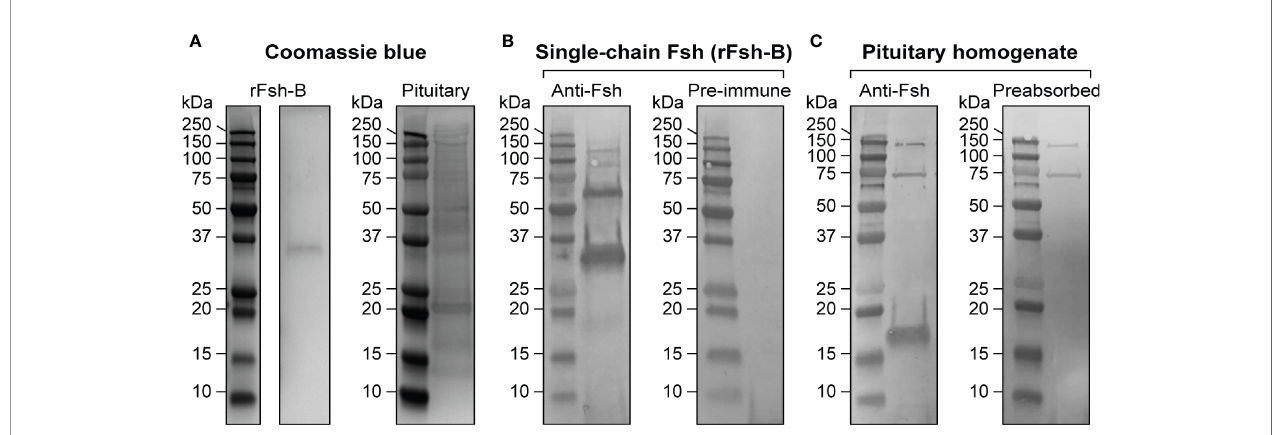
FIGURE 2 | Characterization of a speci fi c antiserum for Atlantic salmon Fsh. (A) Coomassie blue protein staining of the single-chain Fsh protein (rFsh-B) and of a pituitary homogenate. (B) Representative immunoblots of rFsh-B using Fsh antiserum (left panel) and pre-immune serum (as negative control; right panel). (C) Representative immunoblots of a pituitary homogenate using anti-Fsh serum (left panel) and anti-Fsh serum preabsorbed with rFsh-B (as negative control; right panel). In all blots, molecular mass markers (kDa) are shown on the